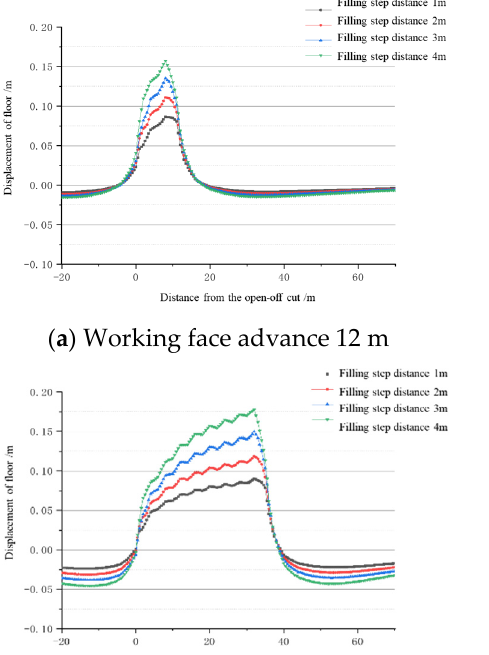
Figure 11. Floor displacement under different filling steps of paste-filling working face.